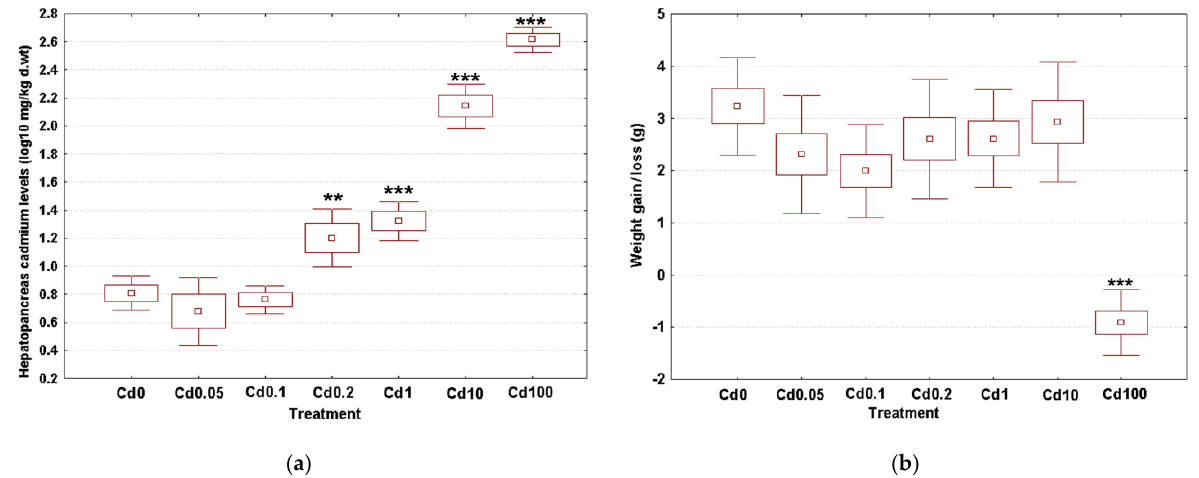
Figure 2. Effect of dietary cadmium on ( a ) hepatopancreas cadmium levels ( n = 4) and ( b ) body weight gain/loss ( n = 8). Metal data are shown on a log 10 scale, whereas weight data are given as absolute values. Data sets are depicted as mean (point) with one standard error (box) and one standard deviation (error bar) (Dunnet’s tests, ***— p < 0.001, **— p < 0.01, *— p < 0.05).